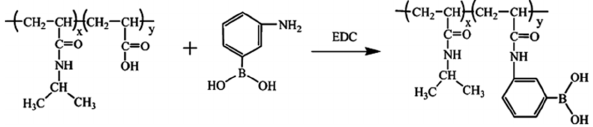
through one-pot thiol-ene copolymerization of pentaery- thritol tetra(3-mercaptopropionate), poly(ethylene glycol) diacrylate, methoxyl poly(ethylene glycol) acrylate and N - acryloyl-3-aminophenylboronic acid [44]. The release